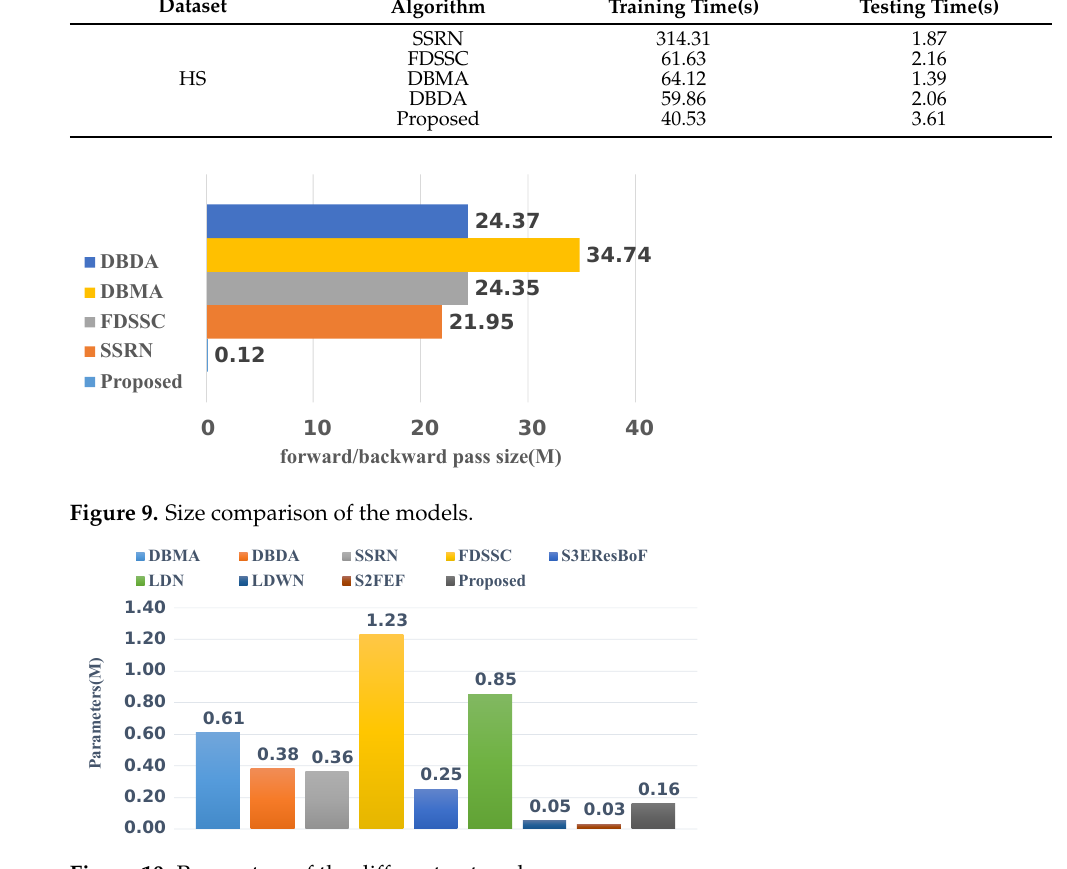
Figure 10. Parameters of the different networks.